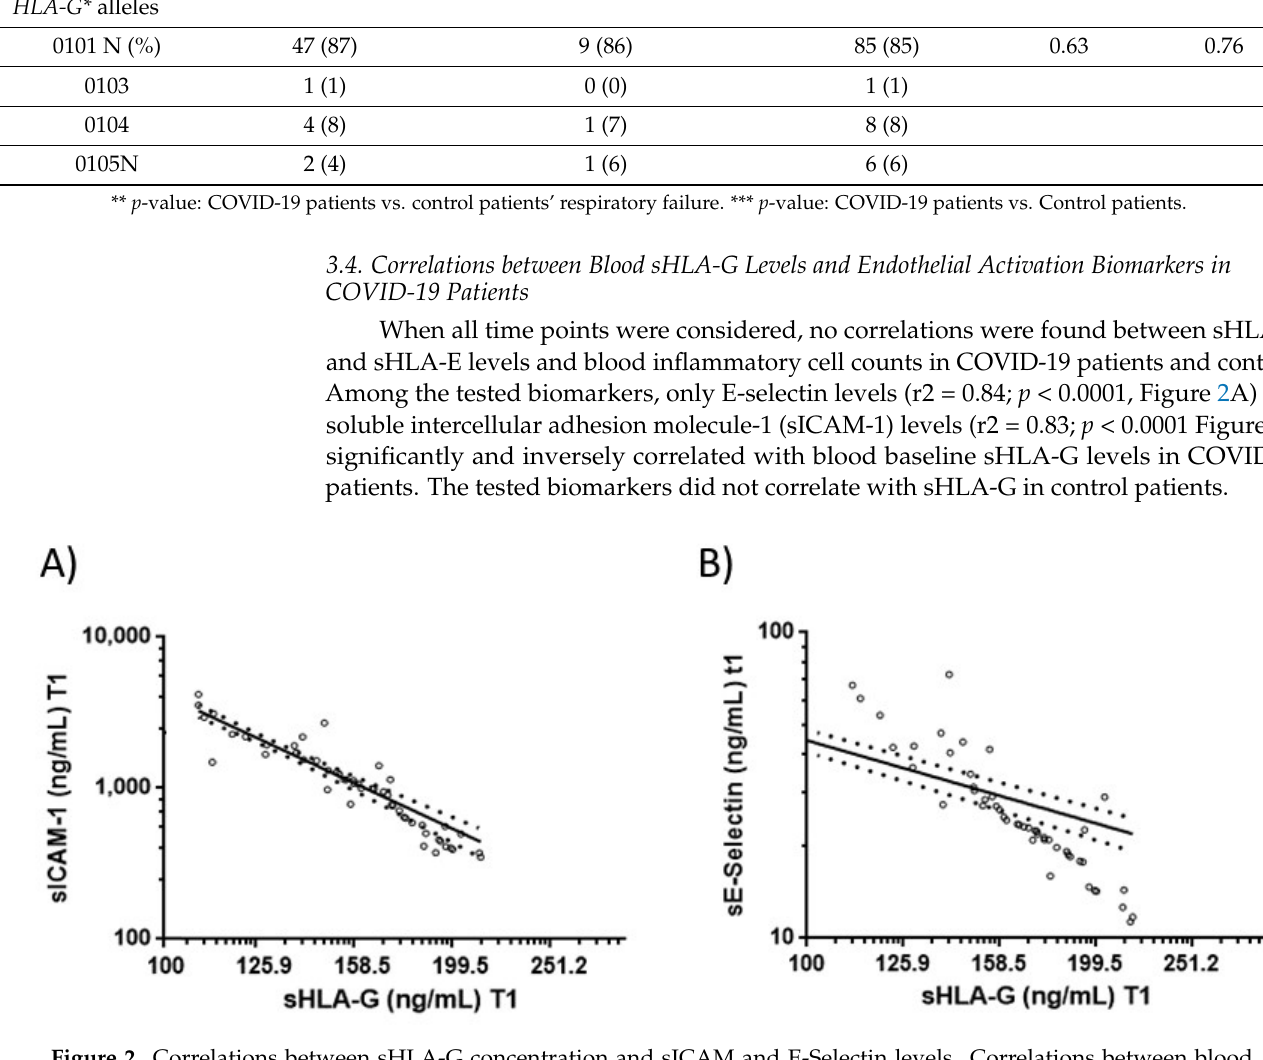
Figure 2. Correlations between sHLA-G concentration and sICAM and E-Selectin levels. Correlations between blood sHLA-G and ( A ) sICAM and ( B ) sE-Selectin levels in COVID-19 patients. Circles: single samples’ values; Line: fitted linear regression line; Dots: data distribution.